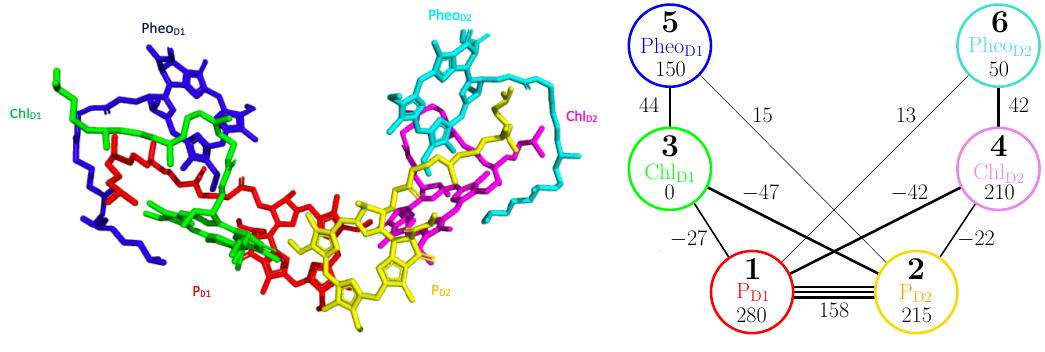
Figure 4. PSII RC pigments selected for the model. ( a ) Configuration of the chlorophylls and pheophytins extracted from PDB 3WU2 [3]. ( b ) FE site energies from Gelzinis et al. [21] and major couplings from Shibata et al. [25]. In each circle, the number on the top is the reference number assigned to the pigment and the number on the bottom is the site energy in units of cm − 1 subtracted by 14,800cm − 1 . Lines connecting the circles indicate FE–FE couplings of an absolute value greater than 10cm − 1 . Their values are shown by the numbers along the line in units of cm − 1